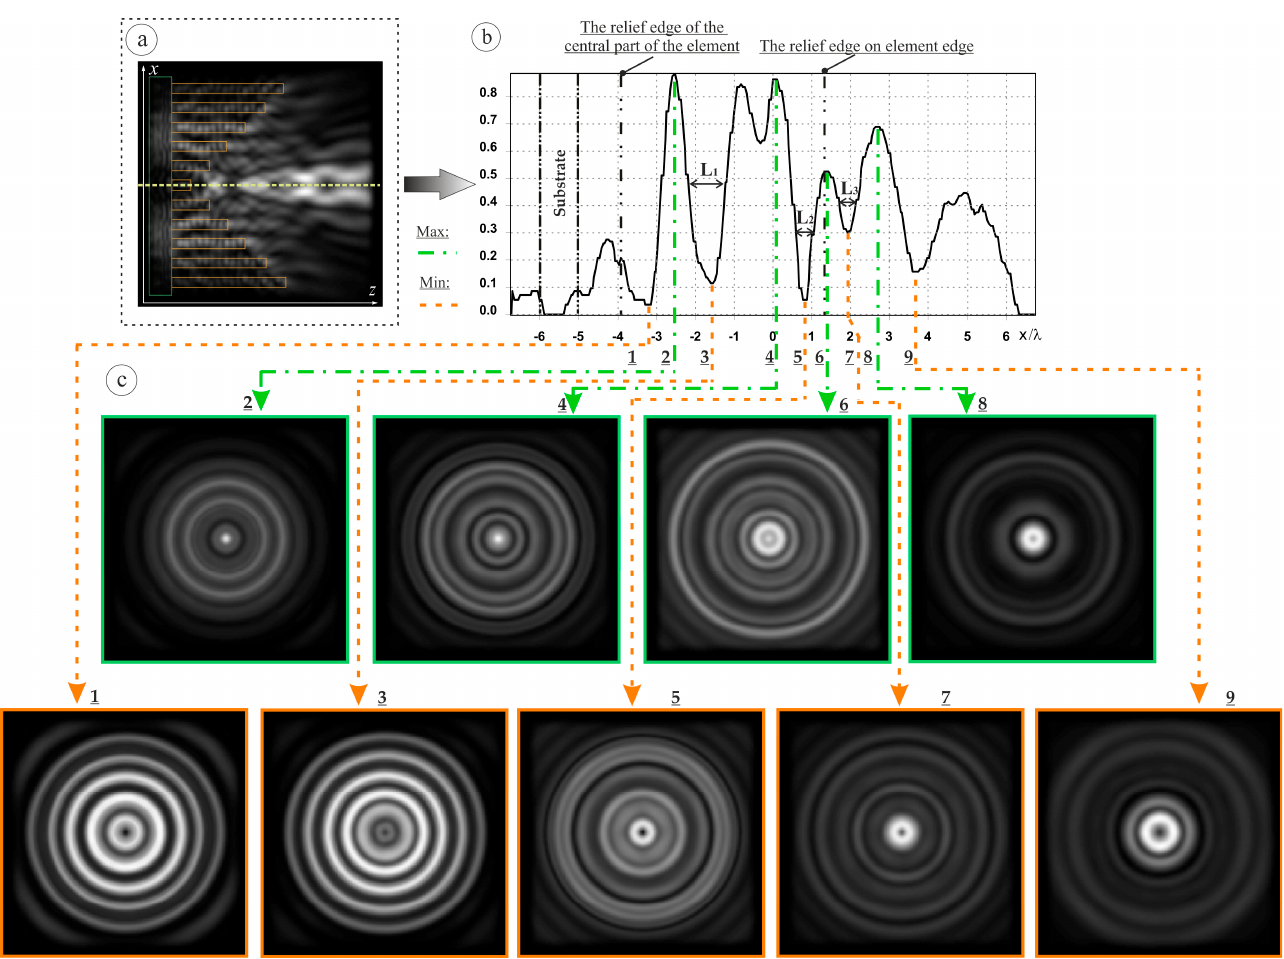
Figure 12. Two-dimensional diffraction pattern of the Laguerre–Gaussian mode (1,0) (see Figure 9f): ( a ) xz plane, ( b ) cross section in the xz plane, and ( c ) cross sections in the xy plane. For a reverse GRIN substrate (Figure 12), a set of three optical traps is